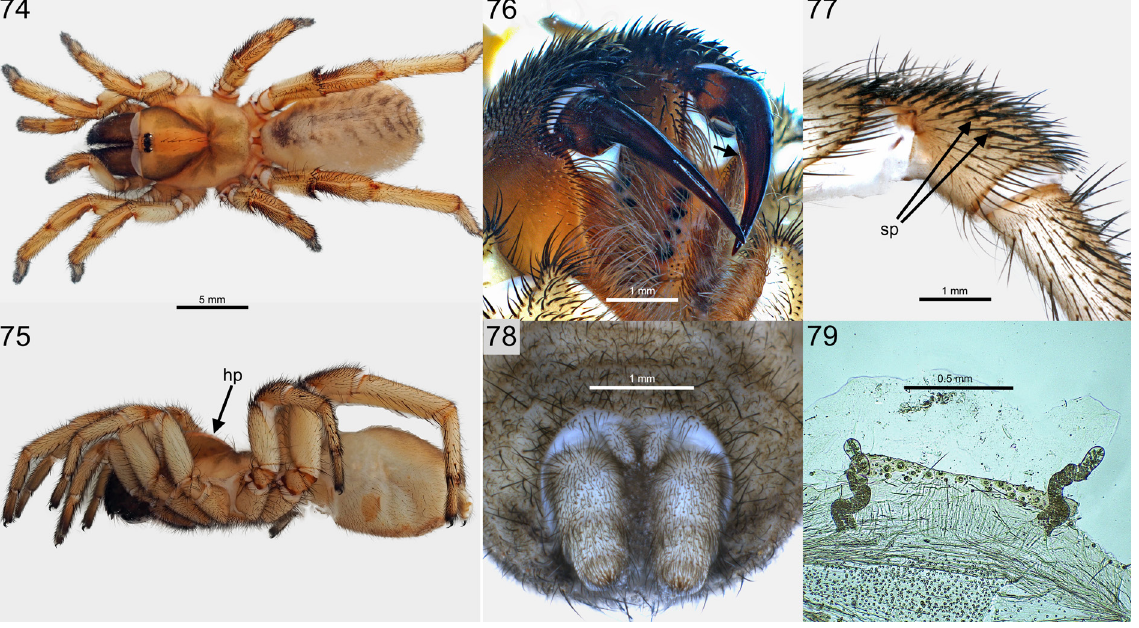
Figs 74–79. Nemesia cominensis sp. nov. holotype, ♀ (TC.002, NHMR). 74 . Dorsal habitus. 75 . Lateral habitus, note the elevated cephalic part or high carapace profile (hp). 76 . Chelicerae in ventro-lateral view, note the hooked fangs and the finely serrated fang-keel (arrow indication). 77 . Prolateral patella III, not the two spines in line (sp). 78 . Spinnerets ventral view, note the digitiform PMS. 79 . Spermathecae with elongated, wavy, wiggly, tube-shaped